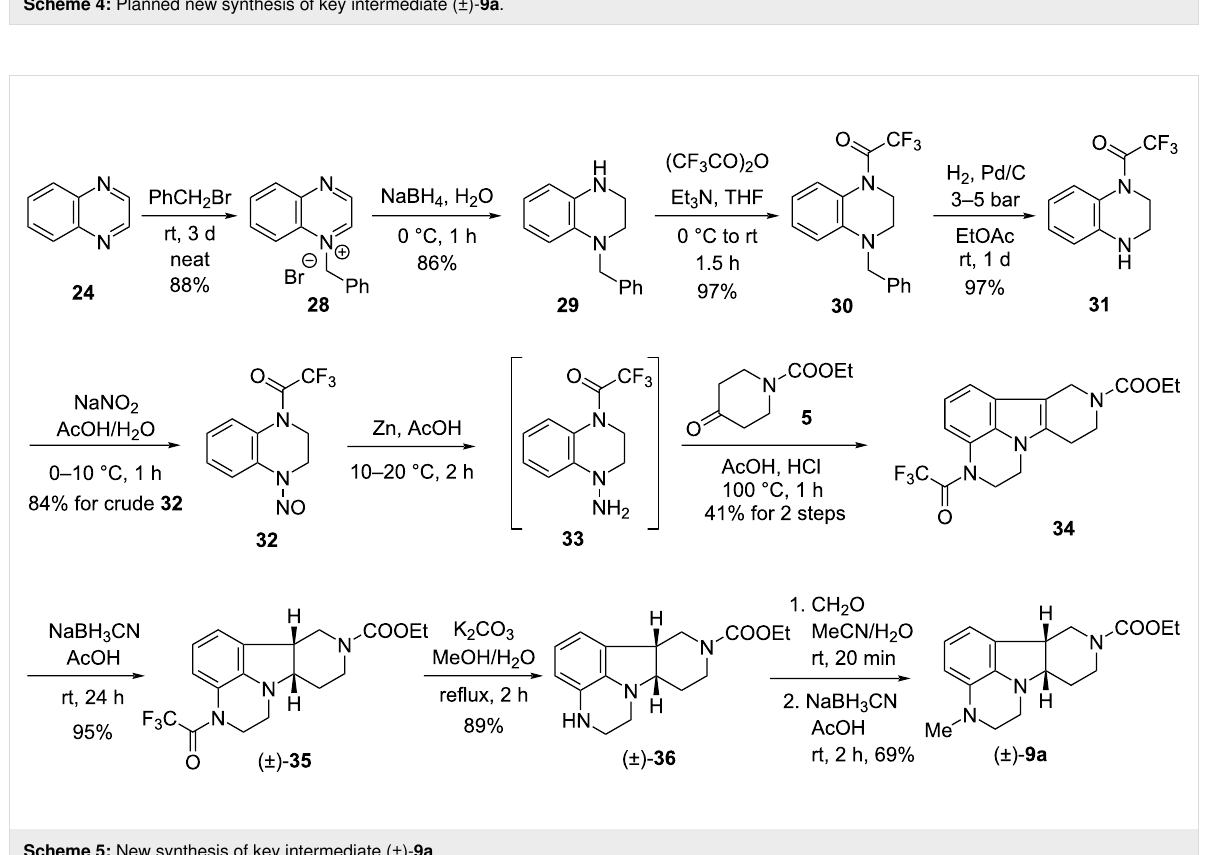
Scheme 4: Planned new synthesis of key intermediate (±)- 9a .